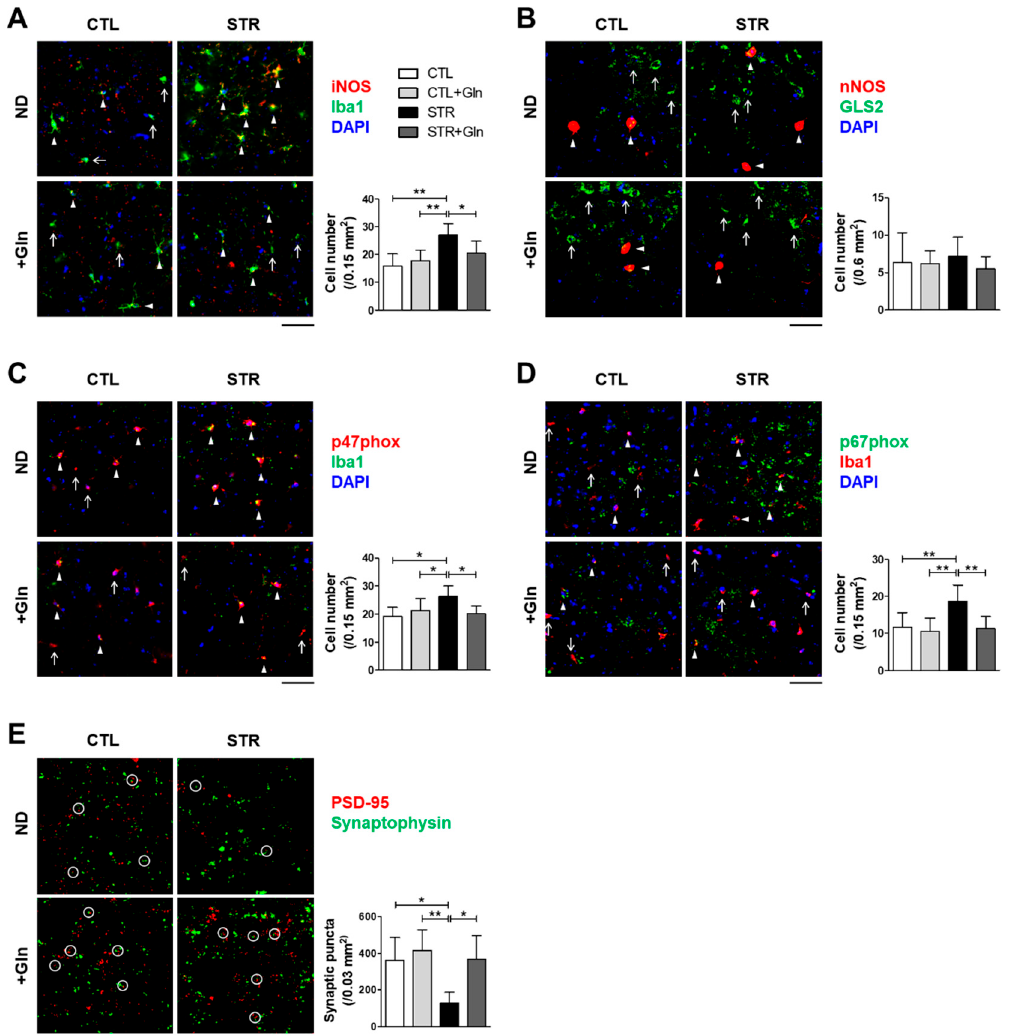
Figure 6. Glutamine (Gln) supplementation prevents both the increase in proteins related to chronic immobilization stress-induced reactive oxygen/nitrogen species (ROS/RNS), and the reduction of synaptic puncta in the infralimbic cortex. ( A–D ) Representative images of infralimbic cortex immunohistochemistry of ROS/RNS production-related proteins with staining for microglial marker Iba1. Arrowheads indicate double-positive cells and arrows indicate cellular marker single-positive cells. Double-positive cell numbers are presented with the images. ( E ) Numbers of synaptic puncta colocalized with PSD-95 and synaptophysin (white circles) in the infralimbic cortex are presented with representative images. Secondary antibody-only controls were performed to confirm specific binding of the primary antibodies (data not shown). * p < 0.05, ** p < 0.01, and *** p < 0.001 values in a one-way analysis of variance followed by Newman–Keuls multiple-comparison tests ( n = 16/group, A-E). Scale bars = 50 μ m. CTL, control; CTL+Gln, Gln-supplemented control; STR, stressed; STR+Gln, Gln-supplemented stressed; ND, normal diet.